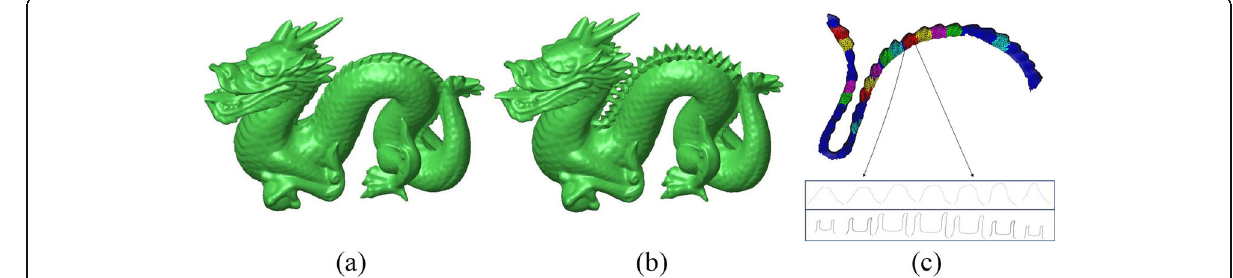
Fig. 5 Illustration for feature editing. a is the left image. b is the middle image. c is the right